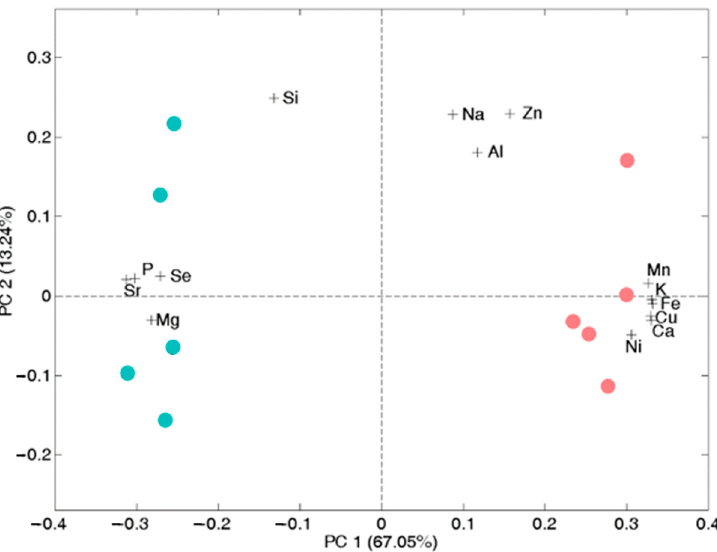
Figure 1. Principal component analysis (PCA) biplot of the mineralized floured samples (explained variance reported in brackets). Orange circles identify AHP samples, light-blue circles identify AHH samples, and plus signs (+) identify variables.